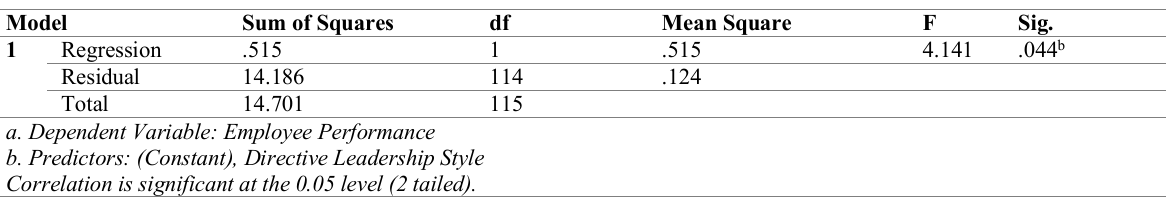
Table 5: Regression ANOVA for Directive Leadership Style and Employee